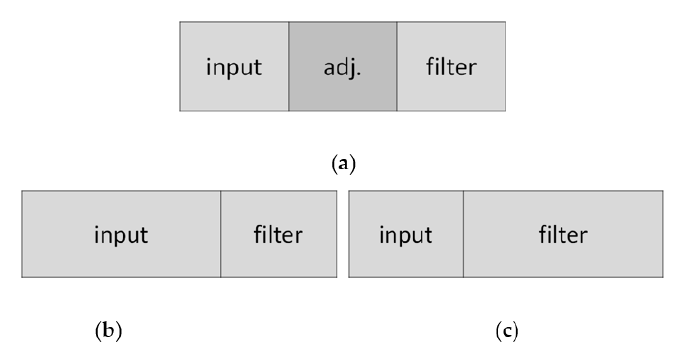
Figure 7. Concept of adjustable buffer configuration ( a ) adjustable buffer ( b ) buffer configuration for ifmap > filter ( c ) buffer configuration for ifmap < filter.